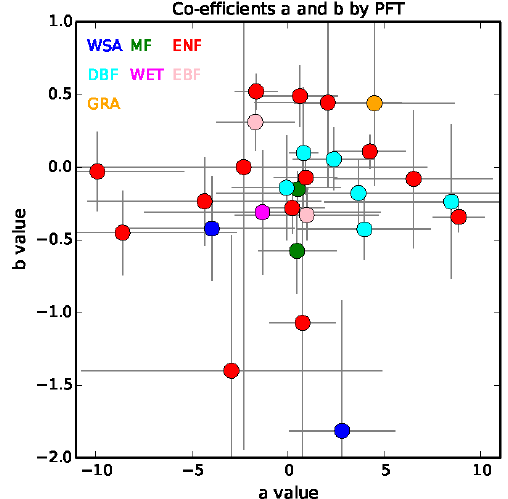
Figure 3. Comparison of best-fit a and b parameters (see Eq. 5) by plant functional type (PFT). Here the sites are organized by domi- nant PFT, using classifications used for the FluxNet sites: evergreen broadleaf forest (EBF), evergreen needleleaf forest (ENF), grass- land (GRA), mixed forest (MF), wetland (WET) and woody savan- nah